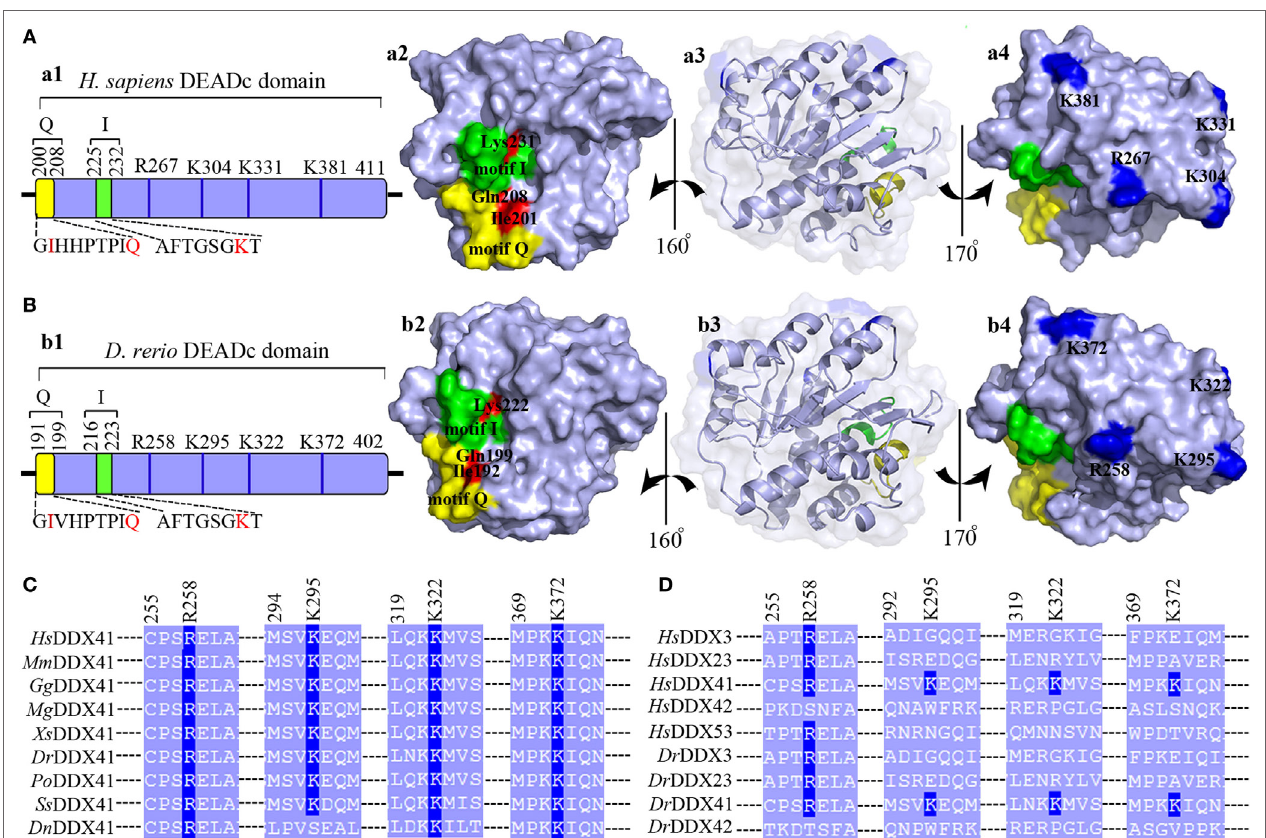
FigUre 2 | Motif organization of the DEADc domain. Schematic diagrams and tertiary structures of the functional motifs in DEADc domains of humans [ (a) , in an APO open form; PDB ID: 5GVS] and zebrafish (B) were presented. (a1,b1) DEADc domain of humans (a1) and zebrafish (b1) contains a motif Q (yellow) and a motif I (green) at its N-terminal region and the key arginine (R) and lysine (K) residues (deep blue) at its C-terminal region (light blue). The color codes representing the motifs and the N- or C-terminal regions are used similarly in the other figures, unless otherwise stated. (a2,b2) Molecular surface representation of the residues involving in recognizing the adenine moiety and the β - and γ -phosphate groups of ATP in Homo sapiens DDX41 ( Hs DDX41) (a2) and Danio rerio DDX41 ( Dr DDX41) (b2) in motif Q and motif I. (a3,b3) Molecular surface and α -helixes and β -sheets representation of DEADc domain in a same view with Figures S4C,D (lower). (a4,b4) Molecular surface representation of the residues involving in the putative double-stranded DNA (dsDNA)/cyclic dinucleotide (CDN) binding (colored in deep blue). (c) Amino acid sequence of the residues near the putative dsDNA/CDN-binding sites of Dr DDX41 and its orthologs (c) , as well as its paralogs (D) . Residues critical for dsDNA or CDN binding are indicated in deep blue. The accession numbers for the sequences of DDX41 and its orthologs and paralogs are shown in Figure